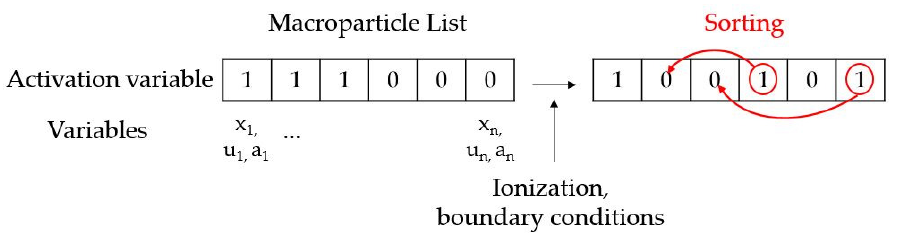
Figure 3. Illustrating the macroparticle list ordering.